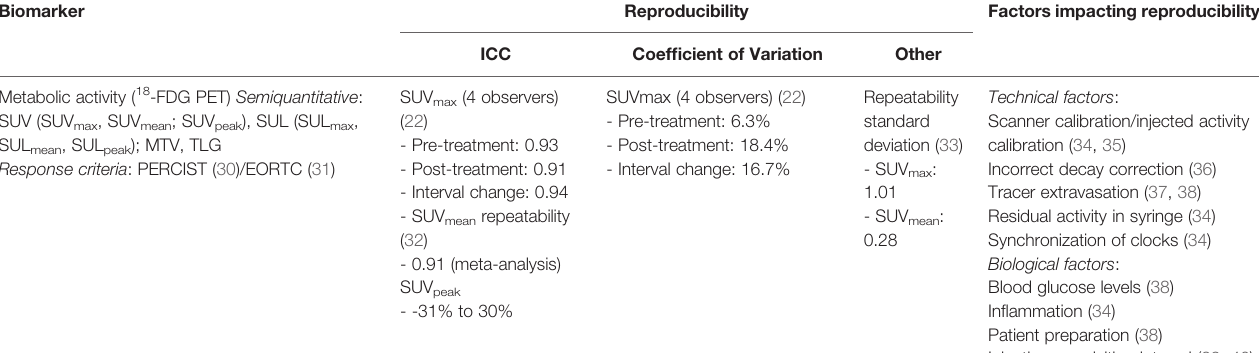
TABLE 4 | Reproducibility and factors impacting it of other imaging